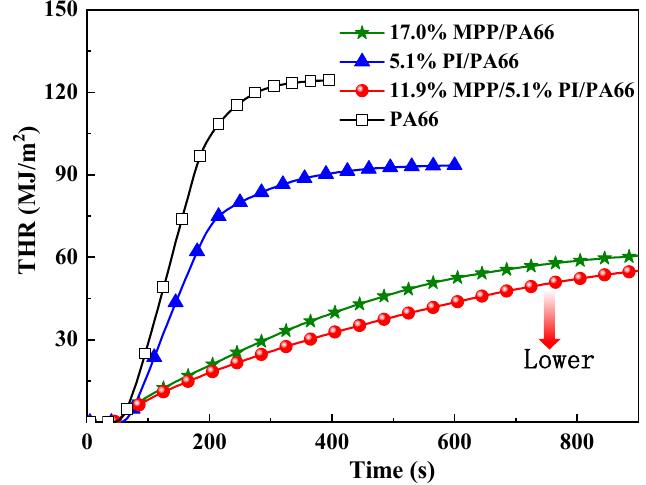
Figure 3. The THR curves of the flame-retardant PA66 composites.